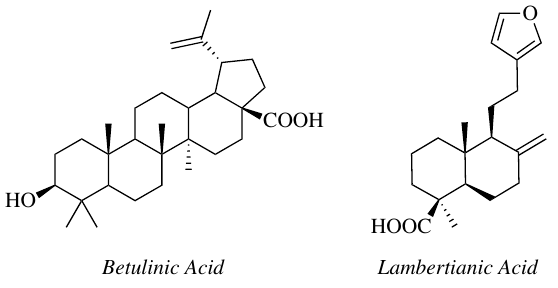
Figure 7. Chemical structure of Betulinic Acid and Lambertianic Acid